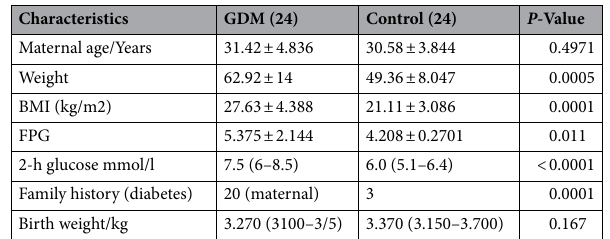
Table 1. Demographics and clinical data of the study population. Data presented as mean ± SD and differences in demographical data were evaluated using ANOVA and T- test. P < 0.05 =